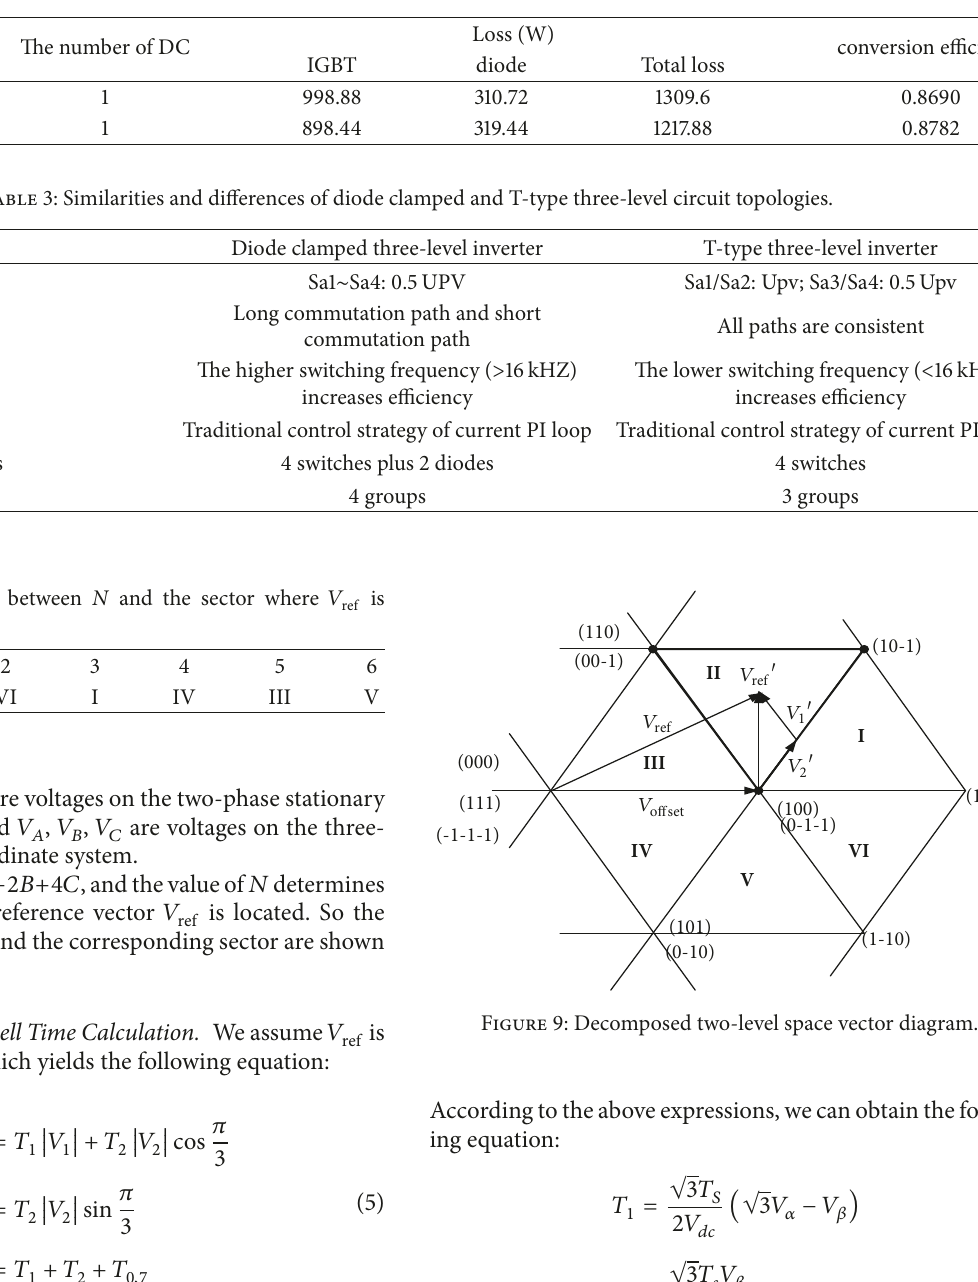
Table 2: The power loss and conversion efficiency of two topologies.